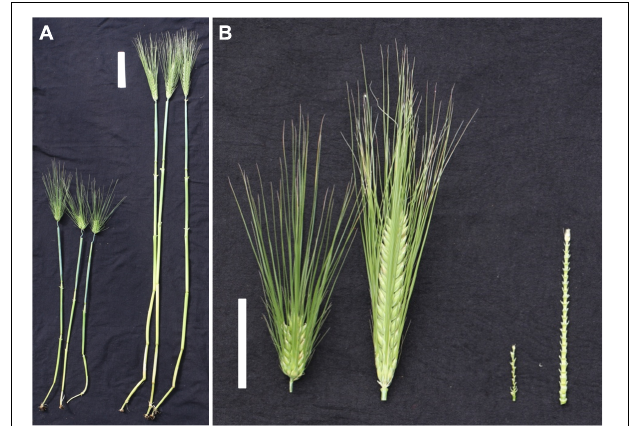
FIGURE 1 | Differences in plant morphology between the mapping parents PI383933 and Rasmusson. (A) Comparison of plant height 2 weeks after heading. White bar equals 10 cm; and (B) Morphology of spikes (left) and rachises (right) reflecting differences in spike density. White bar equals 5 cm. For each comparison, PI383933 is on the left and Rasmusson on the right.